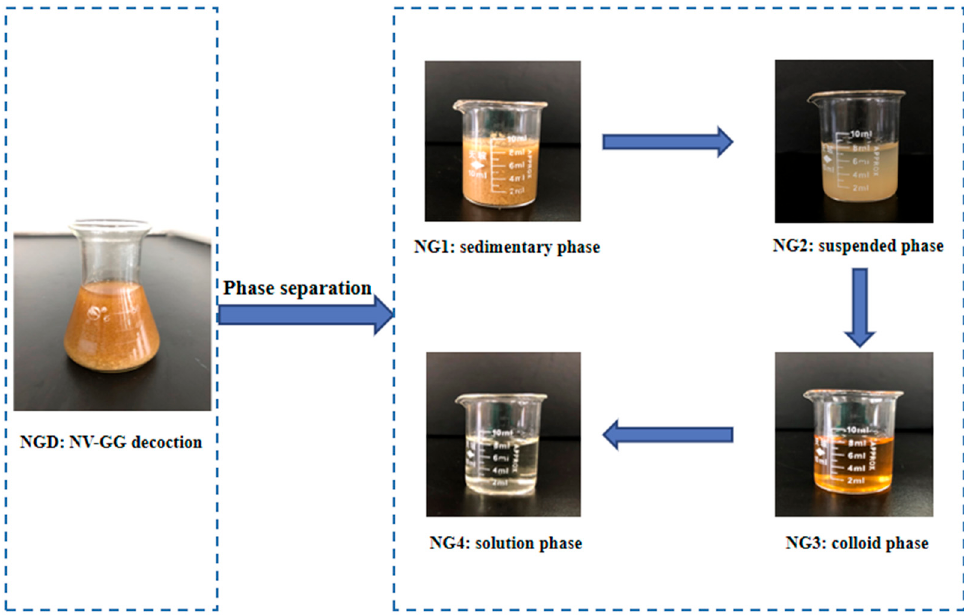
Figure 5. Separation of NGD phase states.